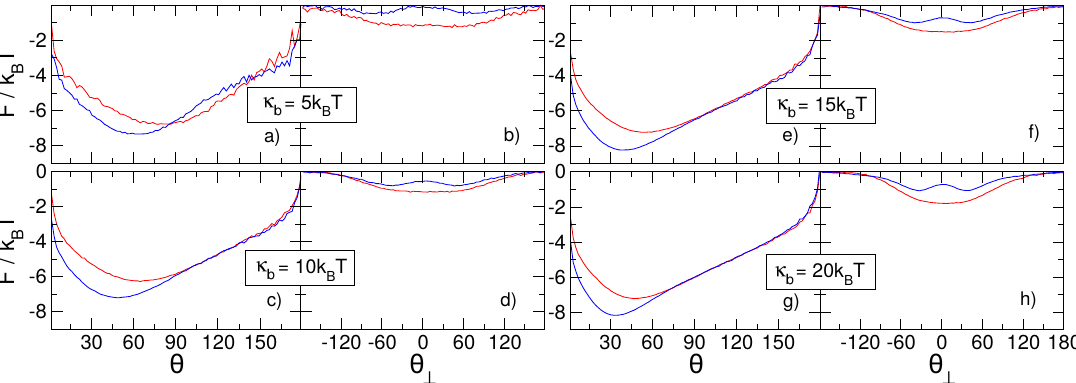
Figure 9. Free energy of two intertwined trefoil knots with the same handedness (red curves) and opposite handedness (blue curves) as a function of θ ( a , c , e , g ) and θ ⊥ ( b , d , f , h ), for four different values of polymer bending rigidity: κ b = 5, κ b = 10, κ b = 15, and κ b = 20 k B T . The free energies have been shifted so that their maximum values correspond to